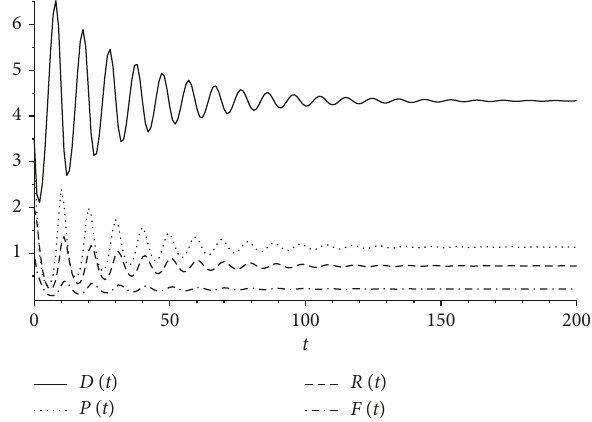
Figure 6: Numerical simulation diagram of system (2) when � 0 . 5 , τ � 5. τ 1 2